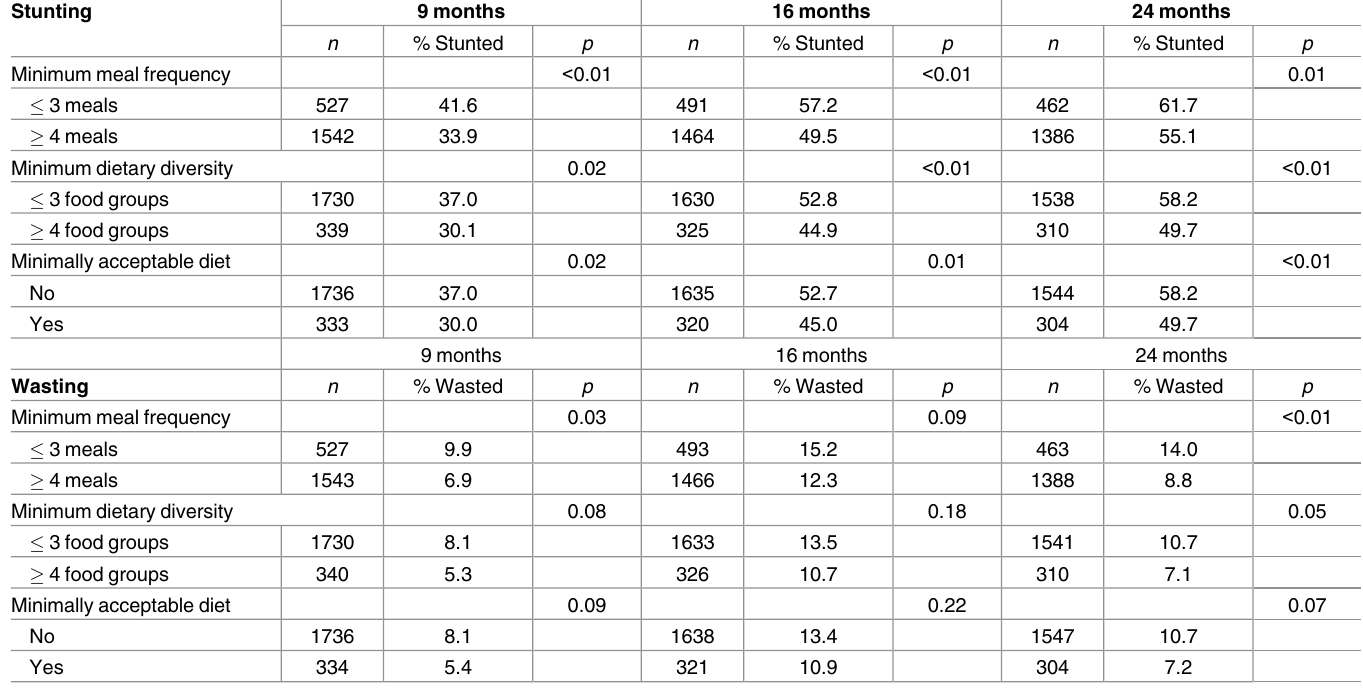
Table 3. Infant feeding practices at age 9 months and prevalence of stunting and wasting in Kishoreganj, Bangladesh. Stunting 9